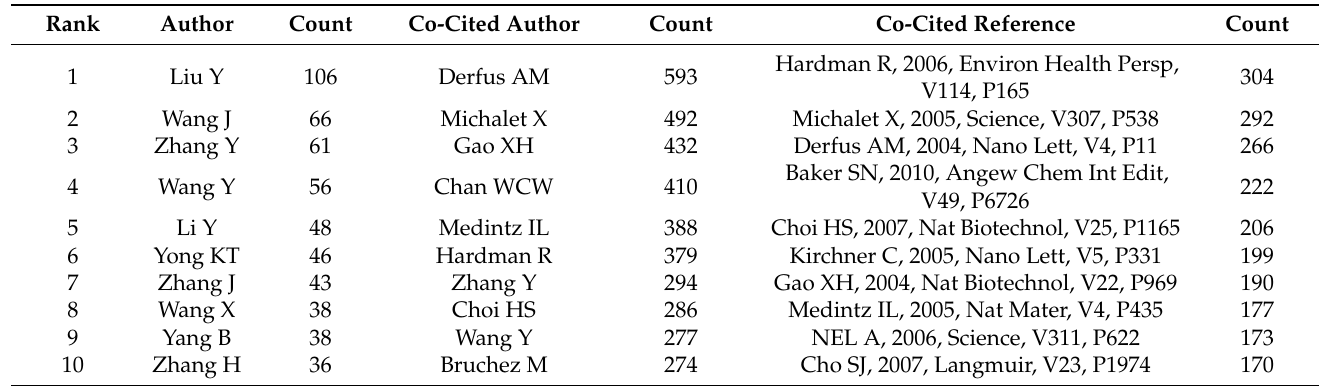
Table 3. The top 10 authors, co-cited authors, and co-cited references in QDs toxicity